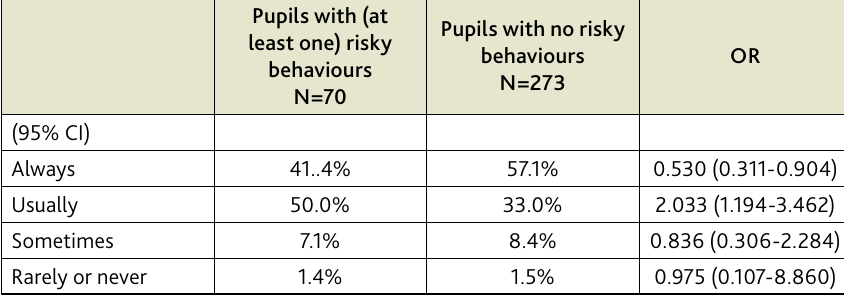
Table 5. Percentage of responses to the question “Do you feel safe where you live?” of respondents with and with no risky